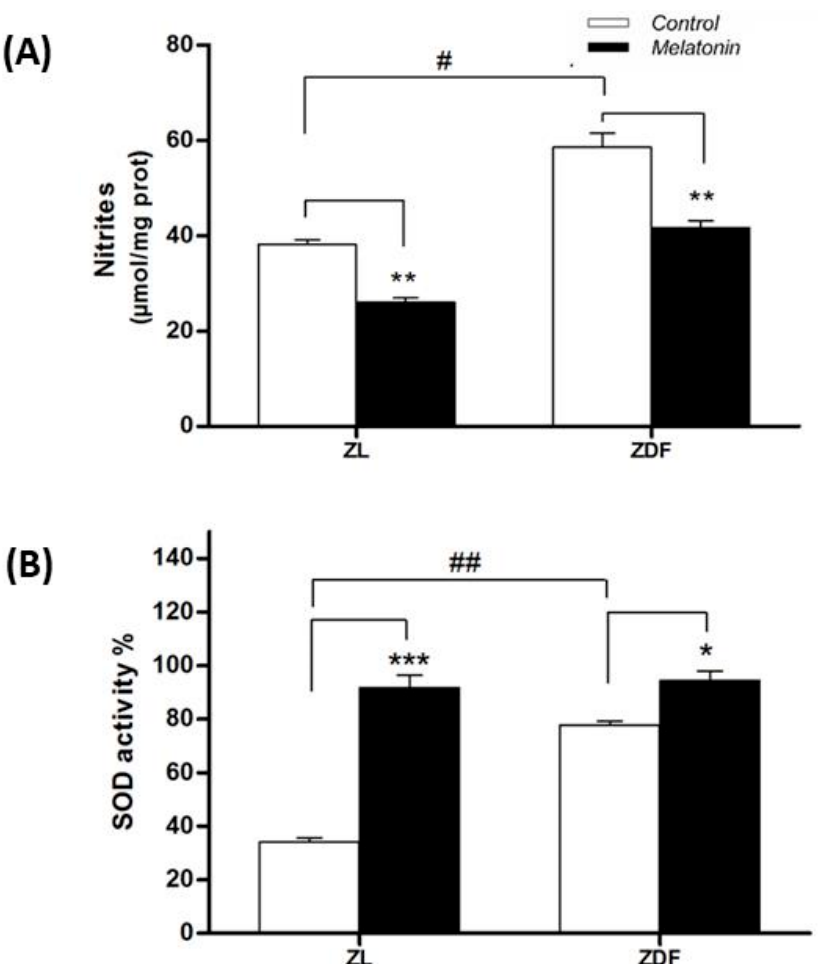
Figure 5. Effect of melatonin on ( A ) nitrite levels and ( B ) superoxide dismutase (SOD) activity in mitochondria isolated from renal tissue. Values are the means ± S.E.M. ZL, Zücker lean rats; ZDF, Zücker diabetic fatty rats. Superscript letters refer to significant difference measured using two-way ANOVA (* p < 0.05, ** p < 0.01, *** p < 0.001 M-ZDF compared with C-ZDF, and M-ZL compared with C-ZL rats; # p < 0.05, ## p < 0.01 C-ZDF compared with C-ZL rats).